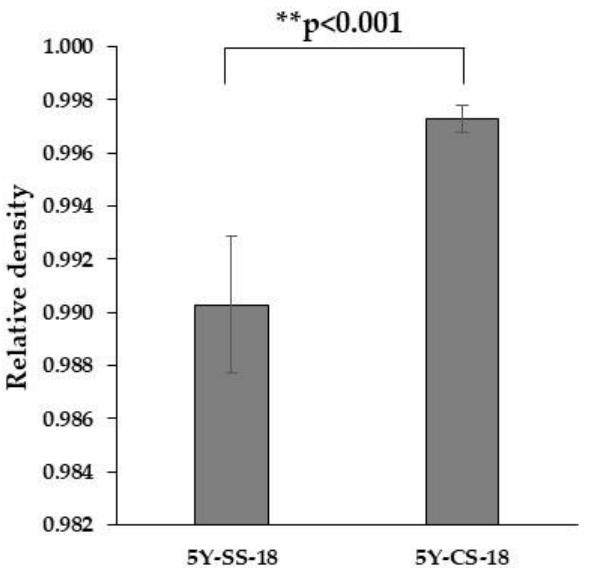
Figure 3. Relative densities of 5Y- SS and 5Y-CS. Two asterisks refer to statistical